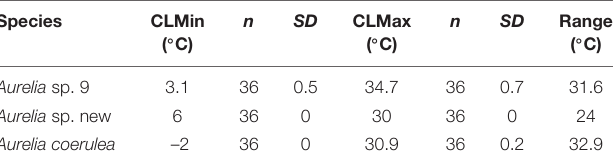
Sample size, standard deviations, and range (CTMax-CTMin) are shown. CLMin and CLMax values are in degrees Celsius ( ◦ C).